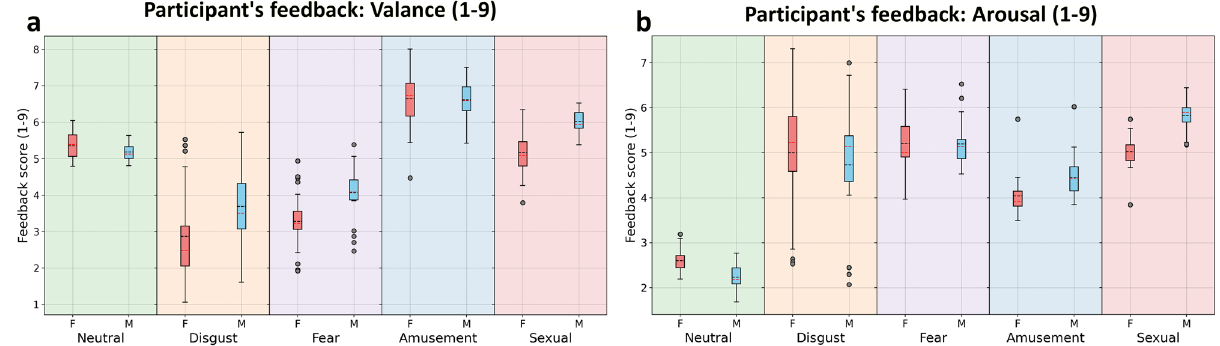
Figure 7. Participant’s feedback summary: ( a ) Valence-question: How did the video you have just watched make you feel on a 1–9 scale? (1 being the most negative, 9 the most positive) ( b ) Arousal-question: How much